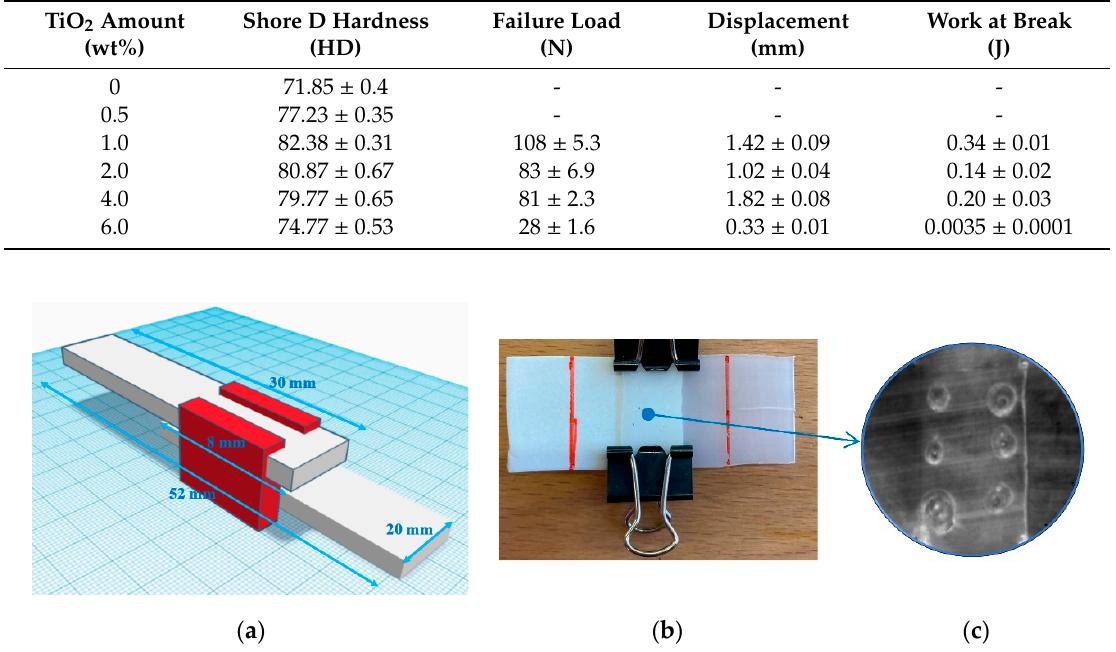
Table 1. Static hardness and tensile test of the nanocomposite joints at different percentages of filler. For a filler amount of 0.5 wt%, the weld process was not obtained.